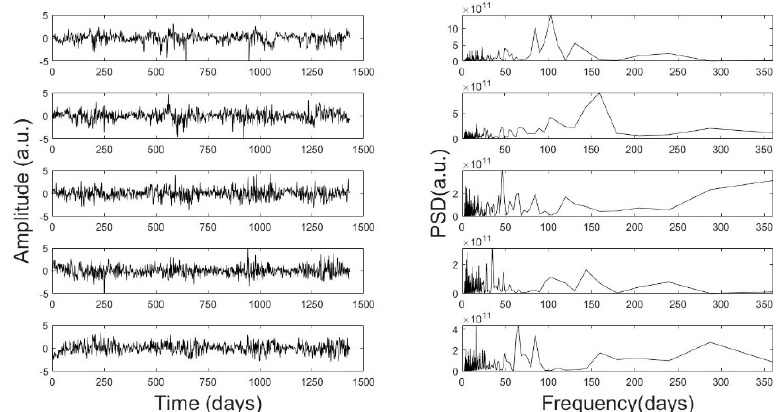
Figure 3. ICA results providing the decomposed independent signals ( left ) with periodicities on the annual scale ( right ).